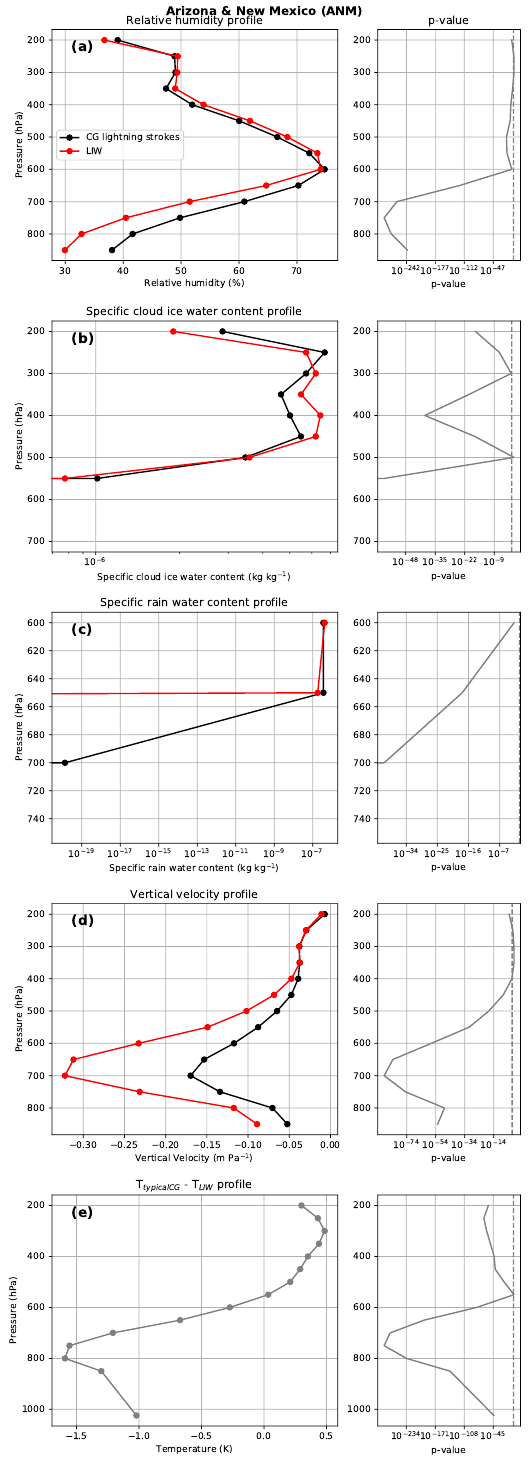
Figure 5. Vertical profiles of the most important meteorological conditions for LIW (red) and typical CG (black) in Arizona and New Mexico. The first column shows the vertical profiles of the median relative humidity ( a ), specific cloud ice water content ( b ), specific rain water content ( c ), vertical velocity ( d ), and temperature difference ( e ) for the CG stroke and LIW climatologies during the fire season in Arizona and New Mexico between 2009 and 2013. The second column shows the p -value (solid line) for each vertical level, which represents the probability of equal medians between both distributions (the dashed line shows the significance limit at 0.05). The p -values were obtained from the Kruskal–Wallis H-tests